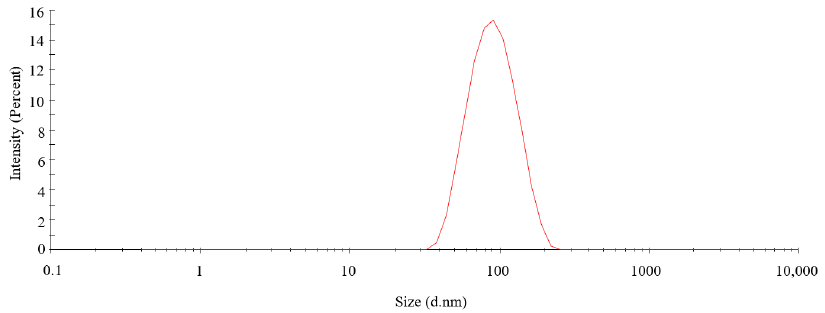
Figure 3. Particle size distribution curve of PtNPs.